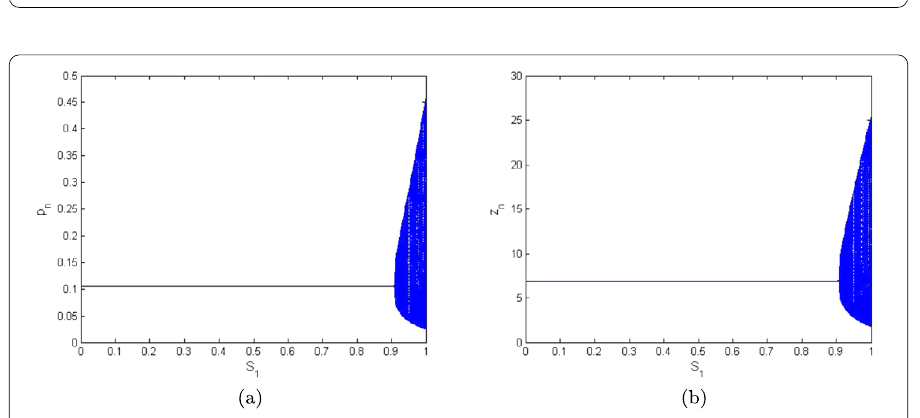
Figure 4 Controlled diagrams for system (7.1) for a = 2.0099, q 1 = 0.0189, q 2 = 1.2994, r = 10.5923, E = 0.9959, k = 1.3997, β = 98.499, α = 2.9999, δ = 0.0384, ρ = 10.5842, m 1 = 0.6222, m 2 = 0.4422, h = 0.699909 and L ∈ (0,1)